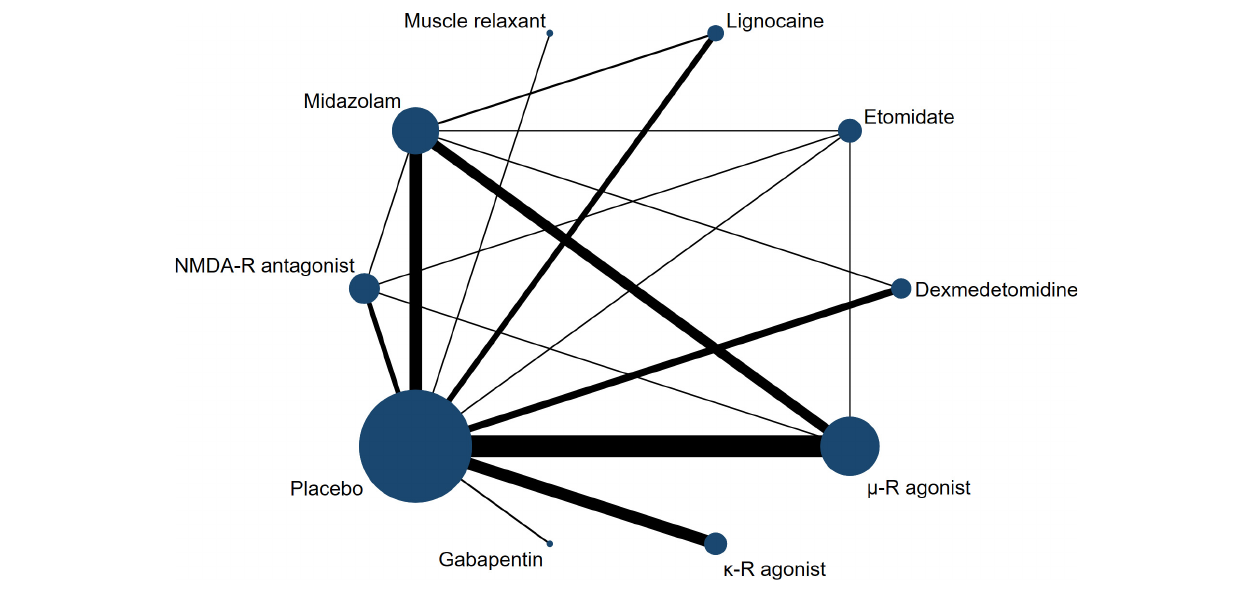
FIGURE 2 | Network plot of treatment comparisons. The width of the line represents the number of RCTs per pairwise comparison, and the size of each node is proportional to the number of sample size.